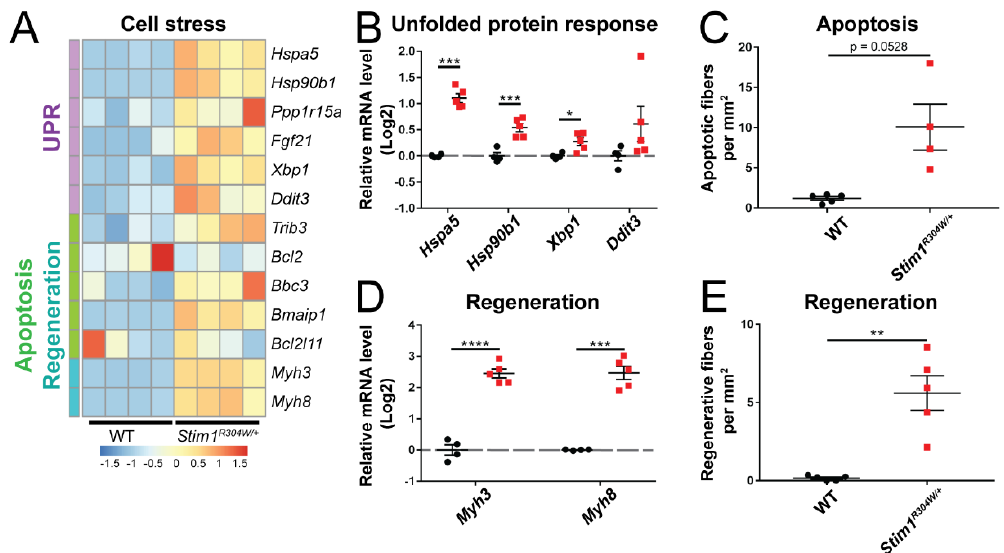
Figure 4. Unsolved reticular stress leading to muscle fiber turnover in Stim1 R304W/+ mice. ( A ) RNAseq heatmap depicting the relative gene expression of genes implicated in unfolded protein response (UPR), apoptosis, and muscle fiber regeneration in Stim1 R304W/+ and WT tibialis anterior ( n = 4). ( B ) RT-qPCR validates the upregulation of genes encoding chaperones ( Hspa5 and Hsp90b1 ), and the XBP1 transcription factor ( Xbp1 ) in Stim1 R304W/+ tibialis anterior ( n = 4–5). ( C ) Apoptotic fibers tend to be more abundant on Stim1 R304W/+ muscle sections than in controls ( n = 4–5). ( D , E ) Upregulation of the embryonic ( Myh3 ) and perinatal ( Myh8 ) myosin genes in Stim1 R304W/+ tibialis anterior, and significant increase of regenerating muscle fibers ( n = 4–5). Significant differences are illustrated as * ( p < 0.05), ** ( p < 0.01), *** ( p < 0.001), and **** ( p < 0.0001).